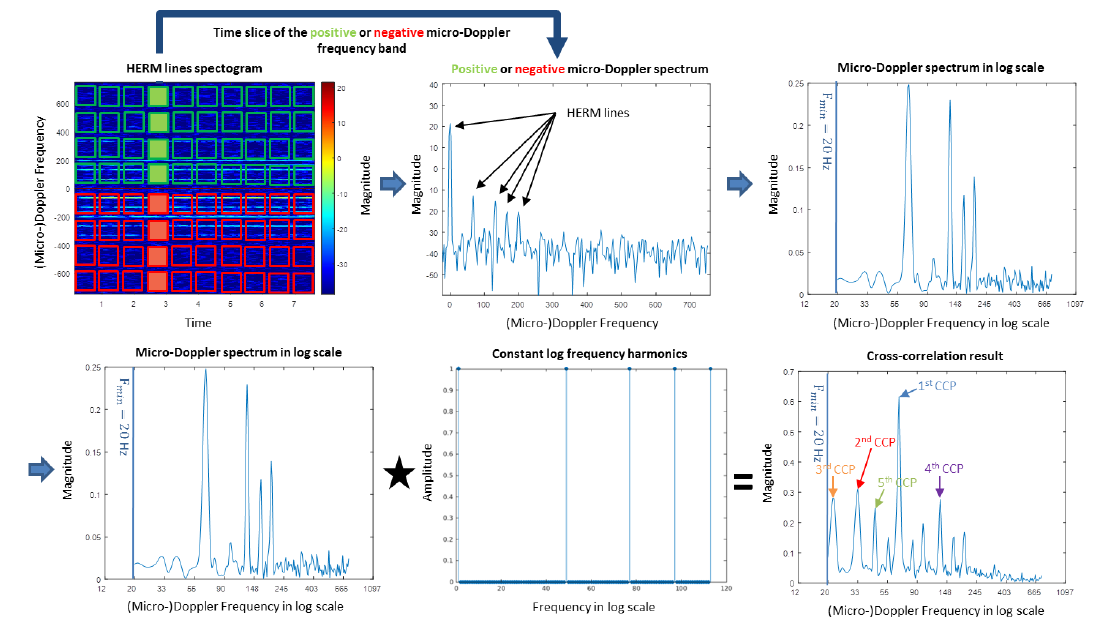
Figure 3. Steps of the log harmonic summation algorithm applied on a HERM lines